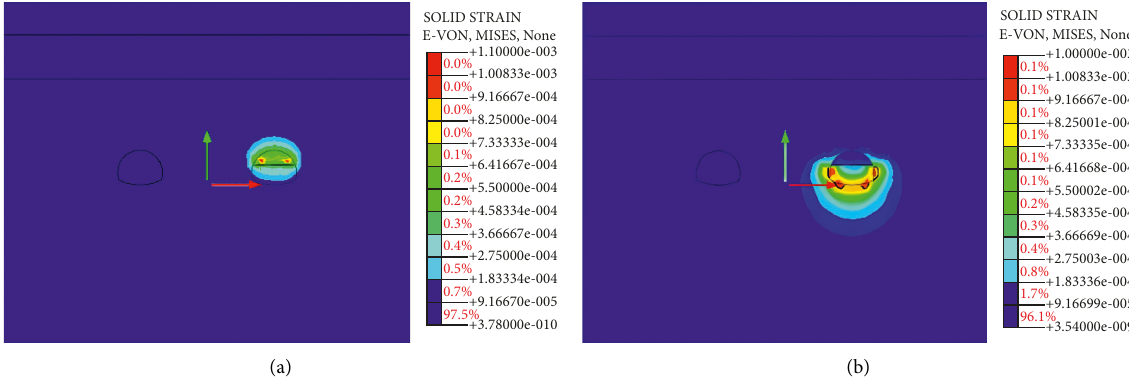
Figure 20: Plastic strain distribution (tunnel clear distance 2D). (a) Excavation of upper step and (b) excavation of lower